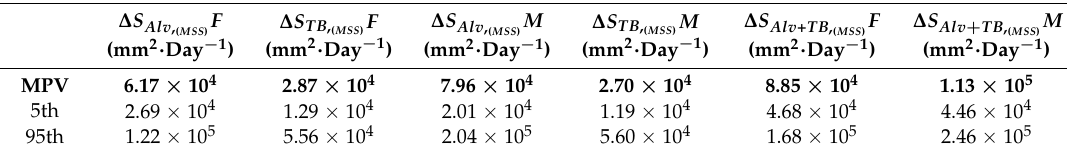
Table 3. Particle surface area doses per day received by smokers in the MSS (“MPV” represents the most probable value of the dose, and 5th and 95th represent the 5th and 95th percentiles, respectively, of the dose values).